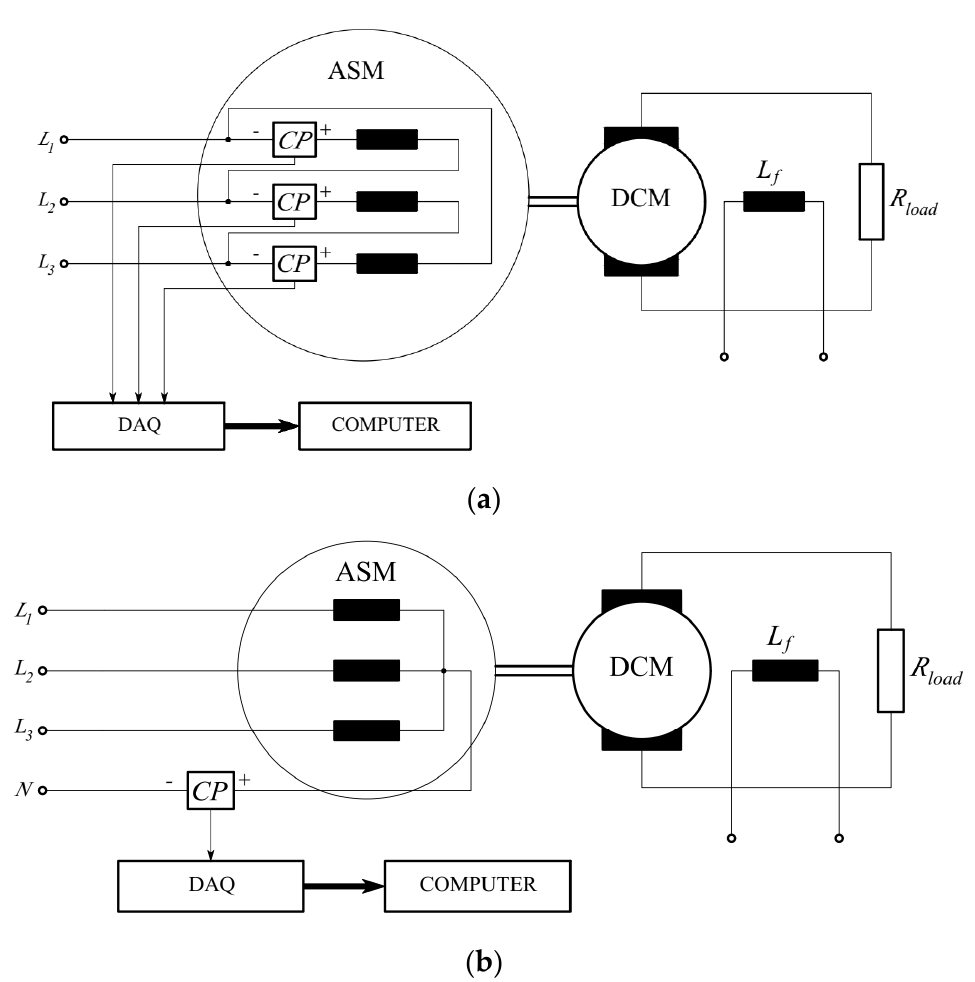
Figure 15. Measurement circuits for the tested motor: ( a ) delta connection; ( b ) wye connection with neutral wire ( ASM = cage induction motor; CP = current probe; DCM = DC generator; R load = resistor; L f = field winding; DAQ = measurement card; N = neutral terminal).